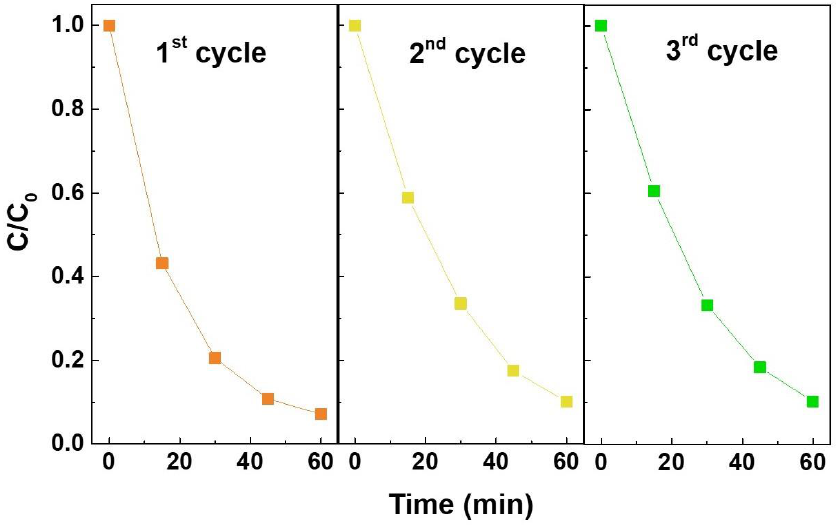
Figure 5. C/C 0 comparison of the photocatalytic degradation of RhB under UV irradiation in the presence of Zn 2 SnO 4 nanoparticles (10 min of synthesis duration). The lines are for eye guiding only.